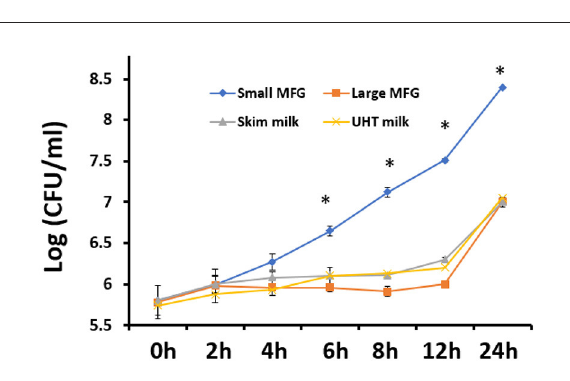
performed at 80 ◦ C for 20 min. Cell numbers after heat killing were quantified by the CFU method using LB agar plates.